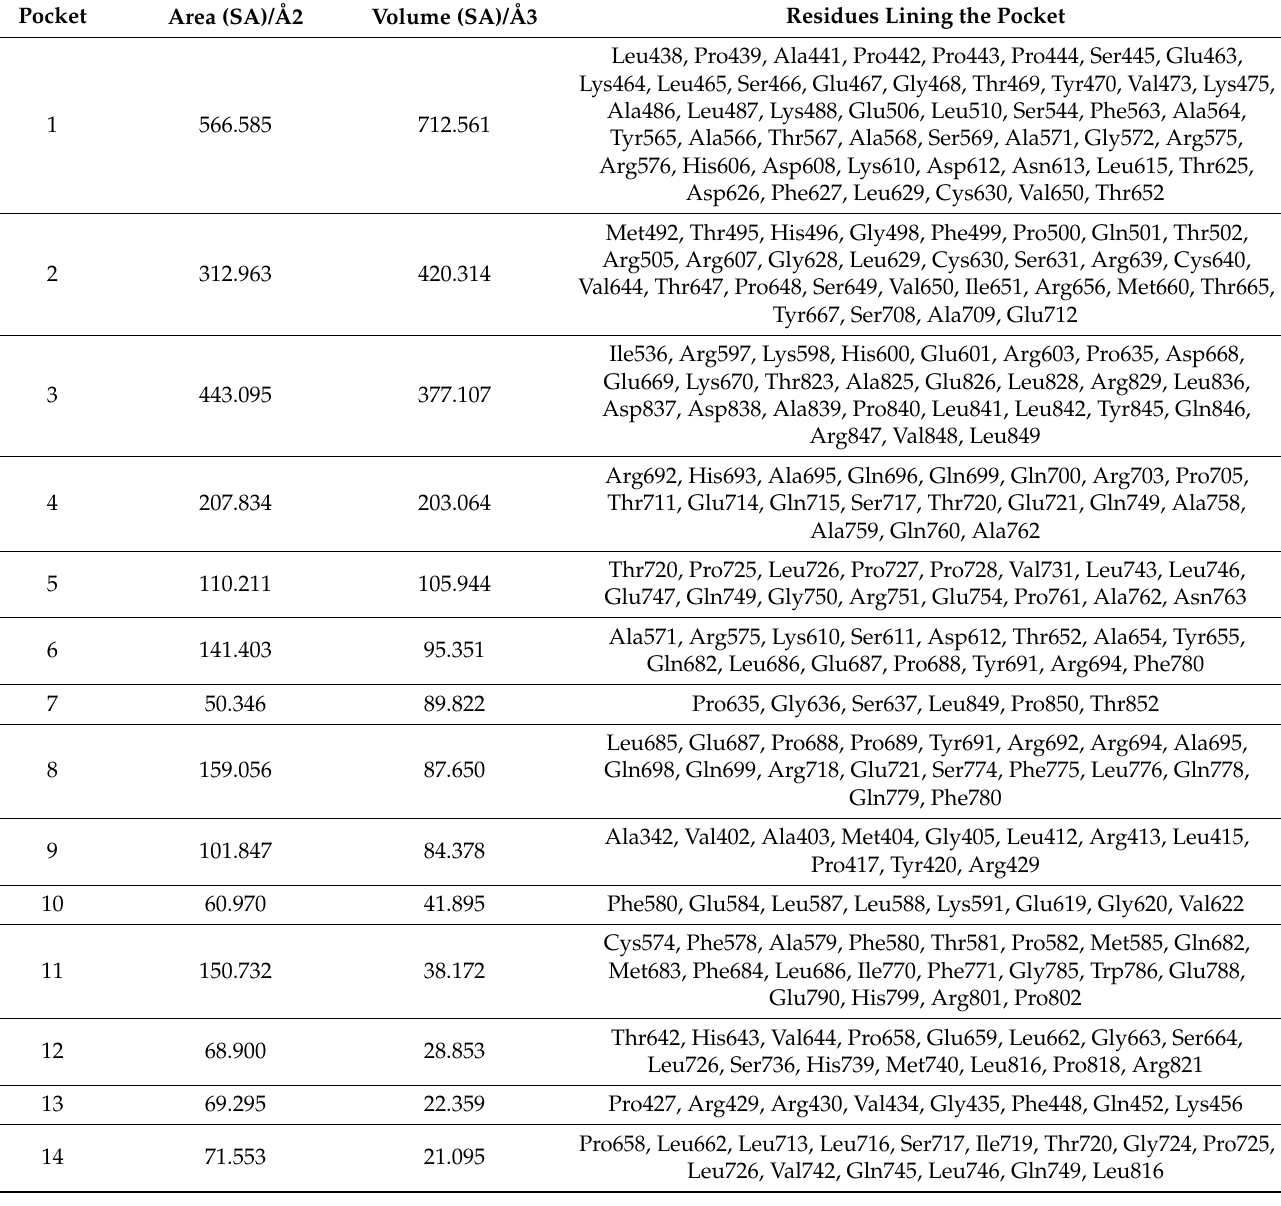
Table 7. Predicted binding sites located around the kinase domain of the Ld CRK12. Solvent accessible (SA) values are